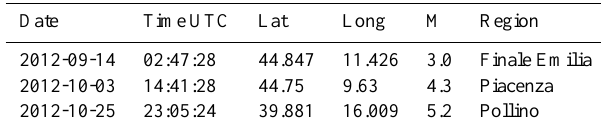
Table 1. List of the events considered in this